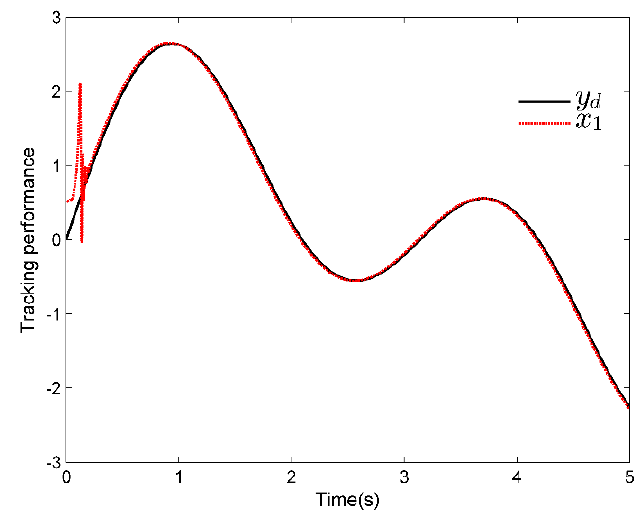
Figure 1. The curves of system output x 1 and reference signal y d .